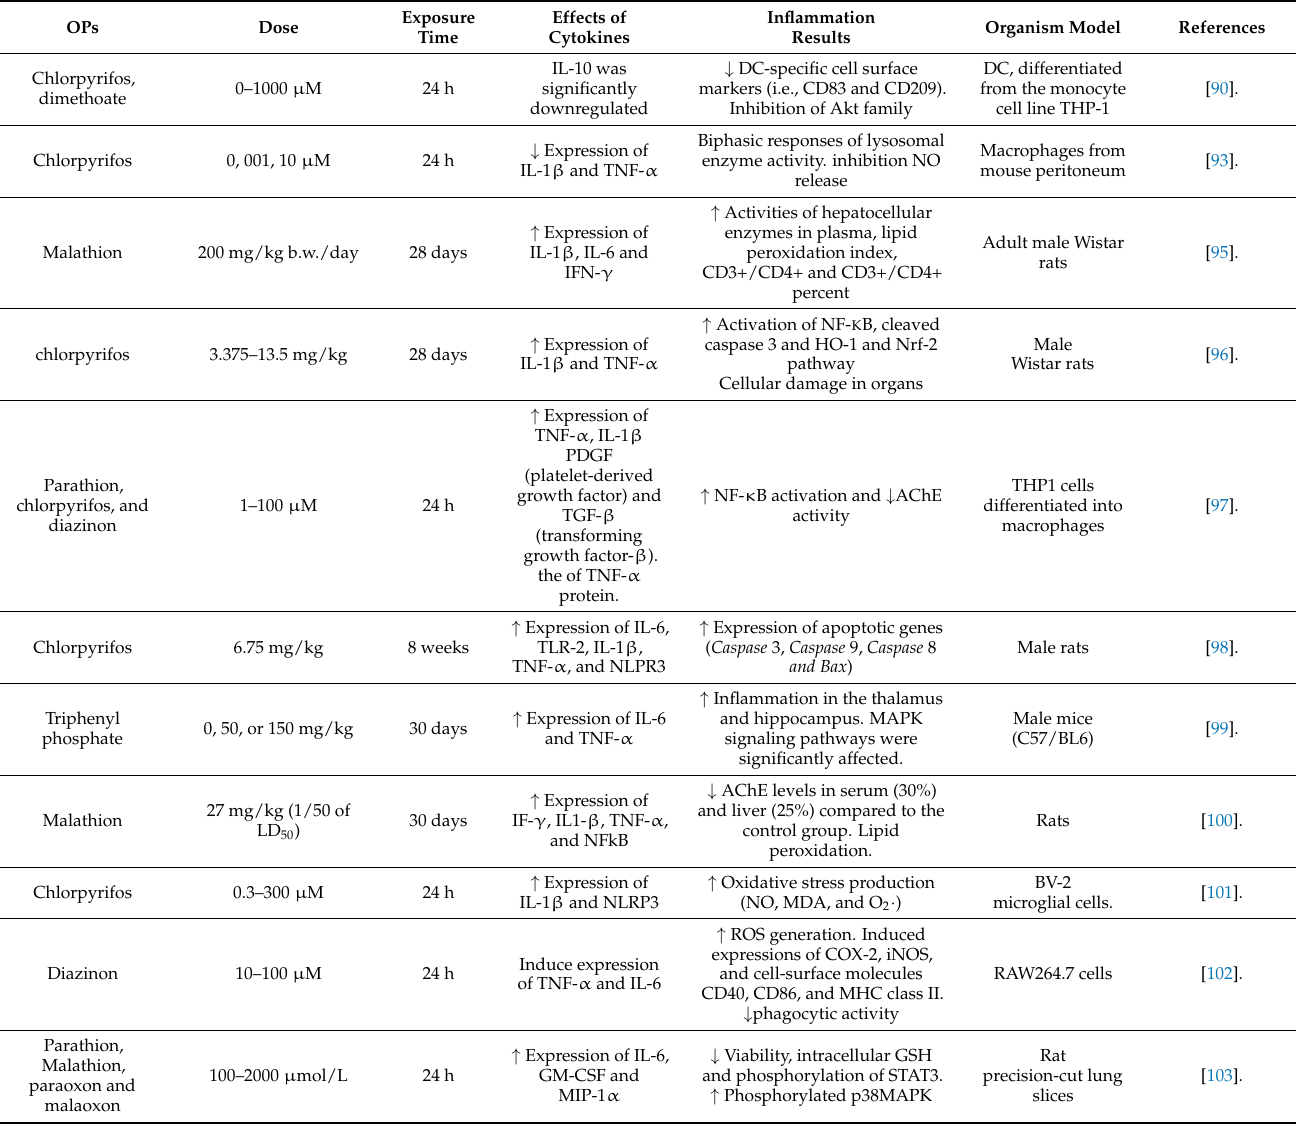
Table 2. Reports of the modulation of the inflammatory process mediated by cytokines due to exposure to